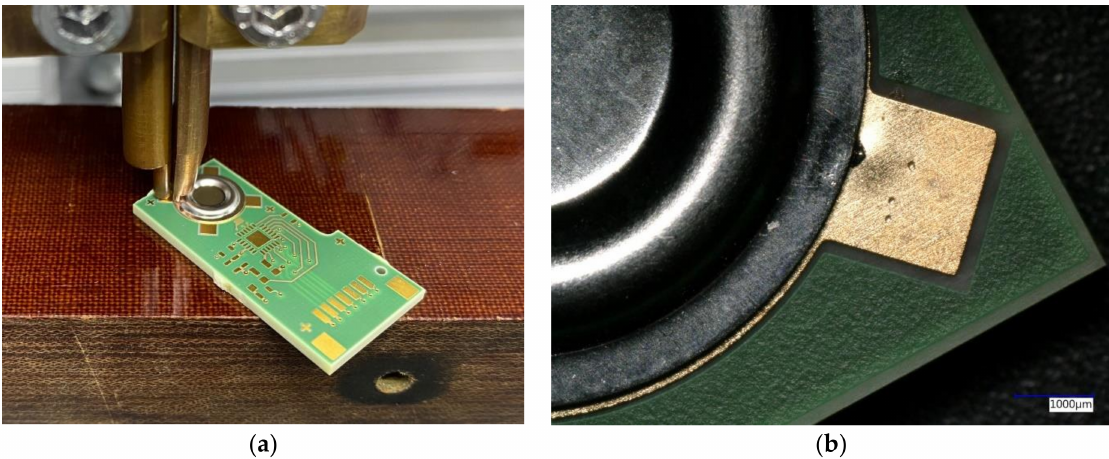
Figure 9. Electric resistance welding: ( a ) welding electrodes; ( b ) single-step welding spot; current = 500 A; pulse duration = 2.5 ms.